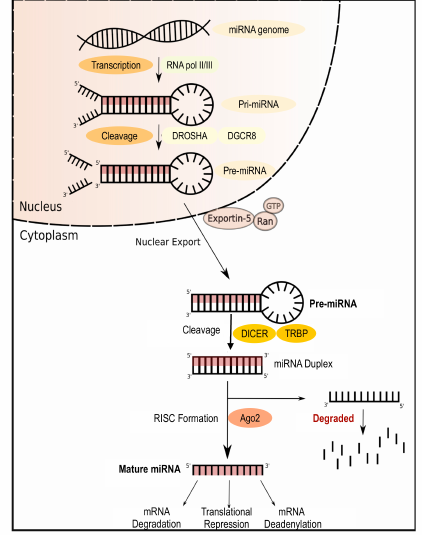
Figure 3. MicroRNA (miRNA) biogenesis and mechanism of action. miRNAs are transcribed in the nucleus as primary miRNA (pri-miRNA) and then cleaved into precursor miRNA (pre-miRNA) by the DORSHA–DGCR8 microprocessor complex. Pre-miRNA is then processed in the cytoplasm by the DICER enzyme, forming a bioactive miRNA duplex which can be bound by the RNA-induced silencing complex ready to target the complementary mRNA for